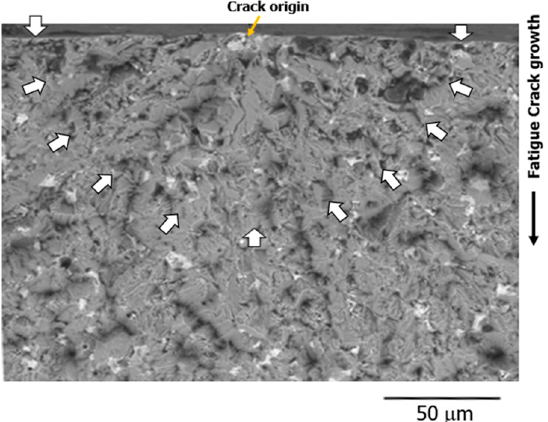
Figure 9. A semicircular surface crack observed on the fracture surface. (Bi, A material, σ max = 330 MPa, N f = 7 × 10 5 ).